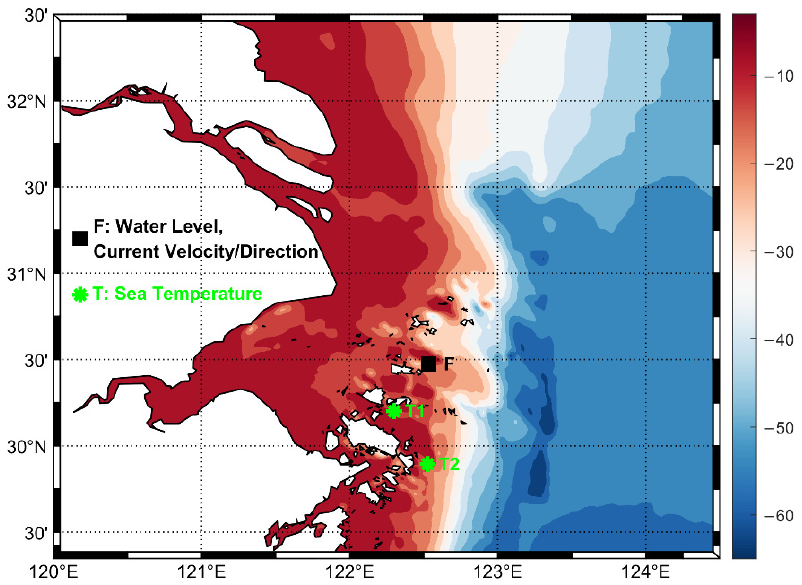
Figure 1. The topography (m) of the CR estuary and adjacent waters. F station is for water level and current. T1 and T2 stations are for sea temperature.